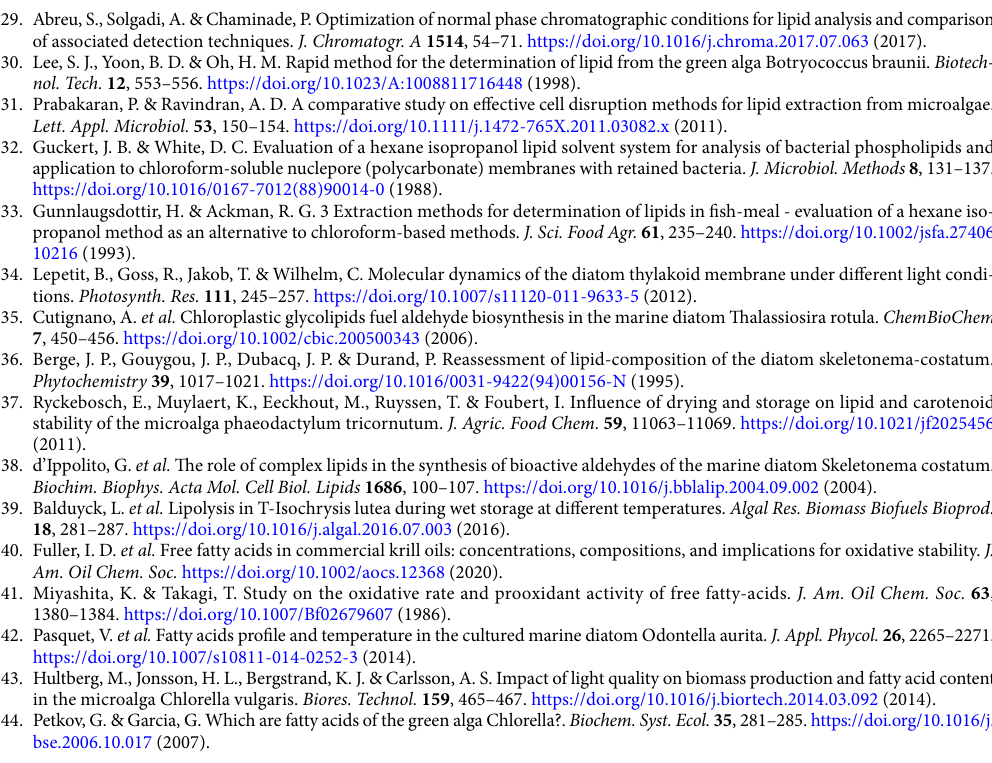
Fig. 1. R.O. and T.V. provided critical revisions of the manuscript. All authors reviewed the final version of the manuscript to be